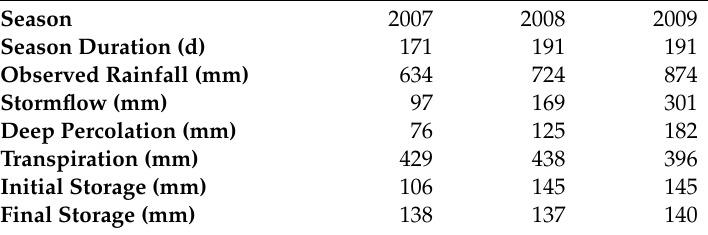
Table 3. Simulated components of the hillslope soil water